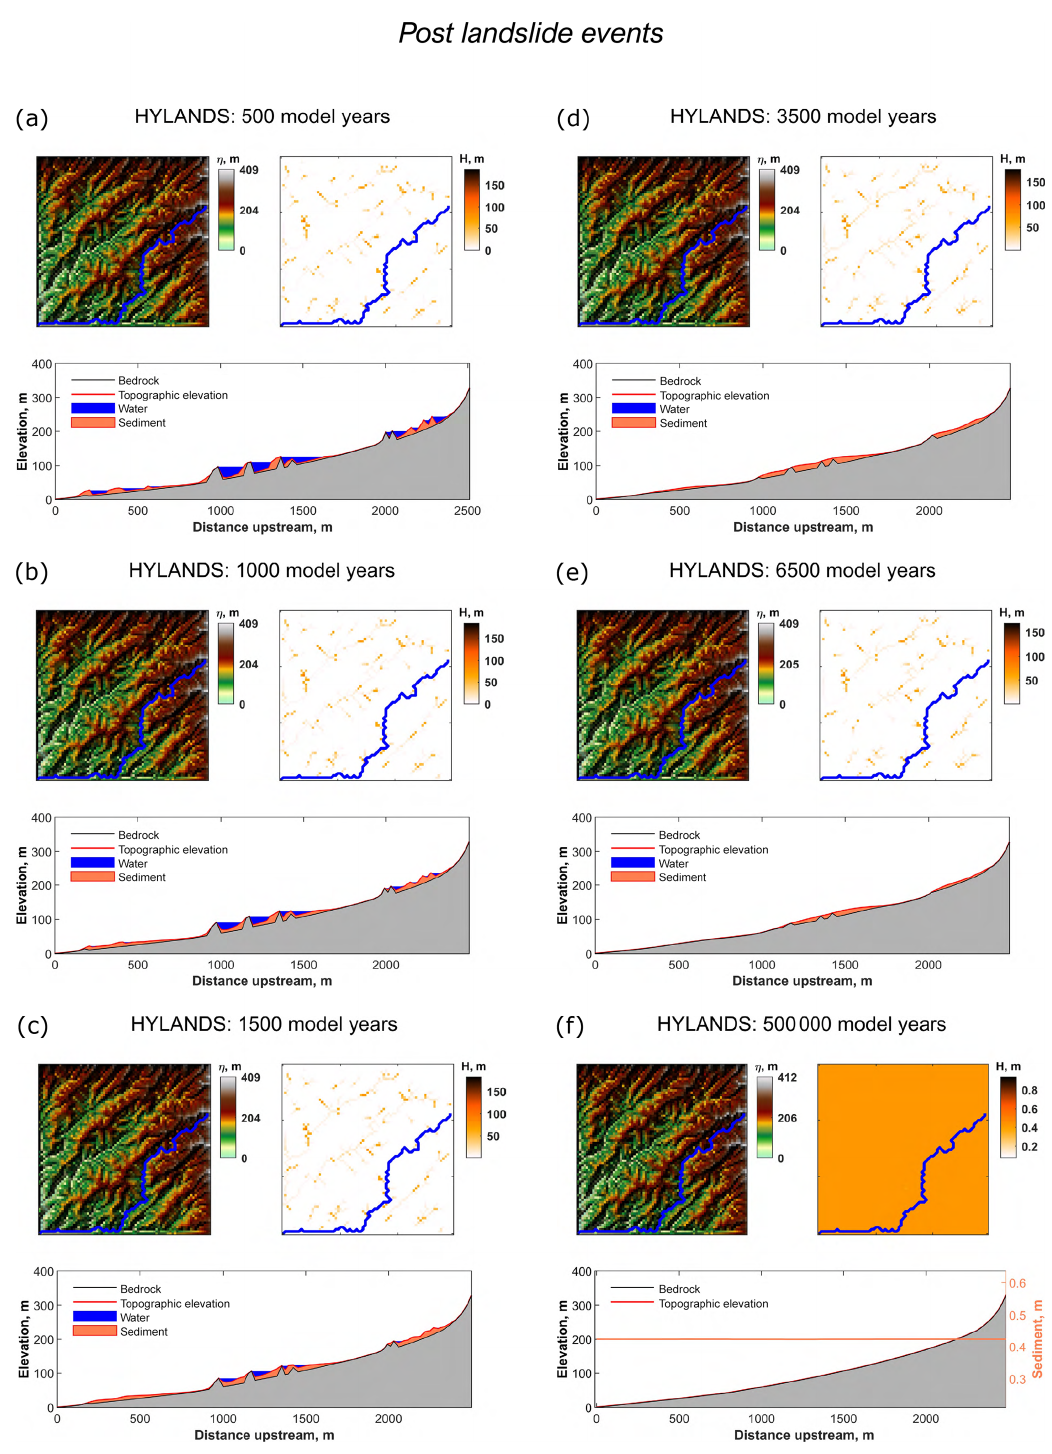
Figure 10. Synthetic model run showing recovery from intense landsliding illustrated in Fig. 9. (a–f) Time slices showing reestablishment of the landscape to steady state. Bedrock bumps created by landslide-induced drainage redirection are eroded, and the channel reattains its smoothly concave-up, steady-state configuration. For a detailed description of subplots and labels, see Fig.